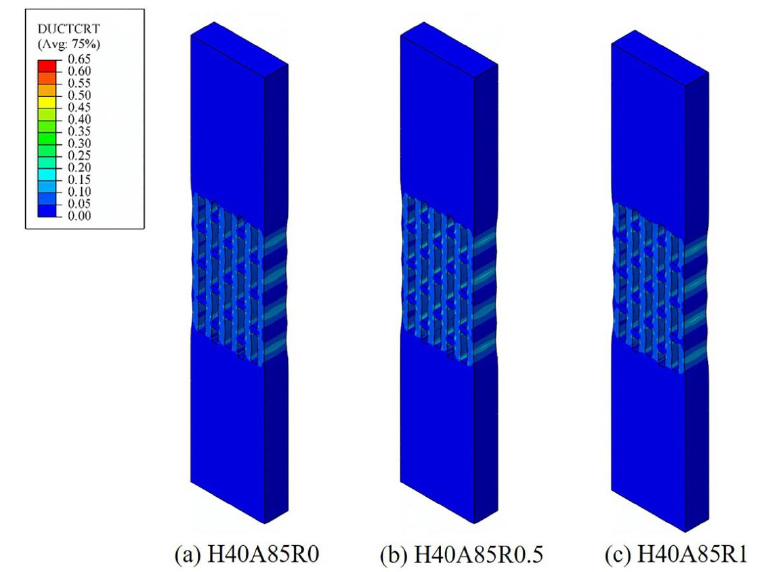
Figure 20. Effect of chamfering radius on equivalent plastic strain with (a) H40A85R0, Figure 20. E ff ect of chamfering radius on equivalent plastic strain with ( a ) H40A85R0, ( b ) H40A85R0.5 and ( c ) H40A85R1. Appl. Sci. 2020 , 10 , x FOR PEER REVIEW